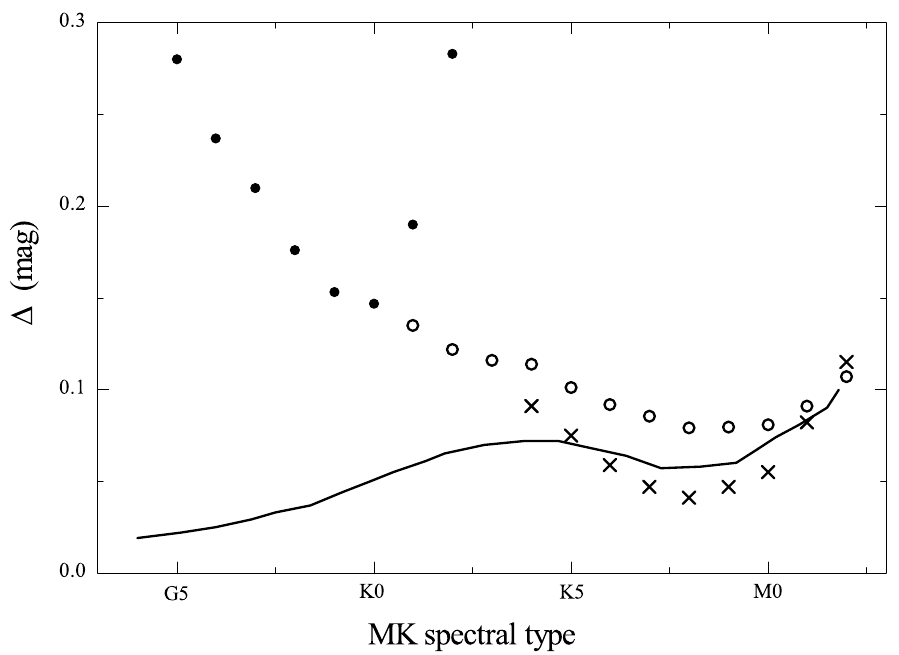
Fig. 2. ∆ values obtained by comparing UBVRJHK magnitudes of BD+20 5152 with analogous magnitudes for various MK spectral types. Dots – only the primary is considered, open circles – a binary system with a G6 V type primary, crosses – a triple system with a G8 V type